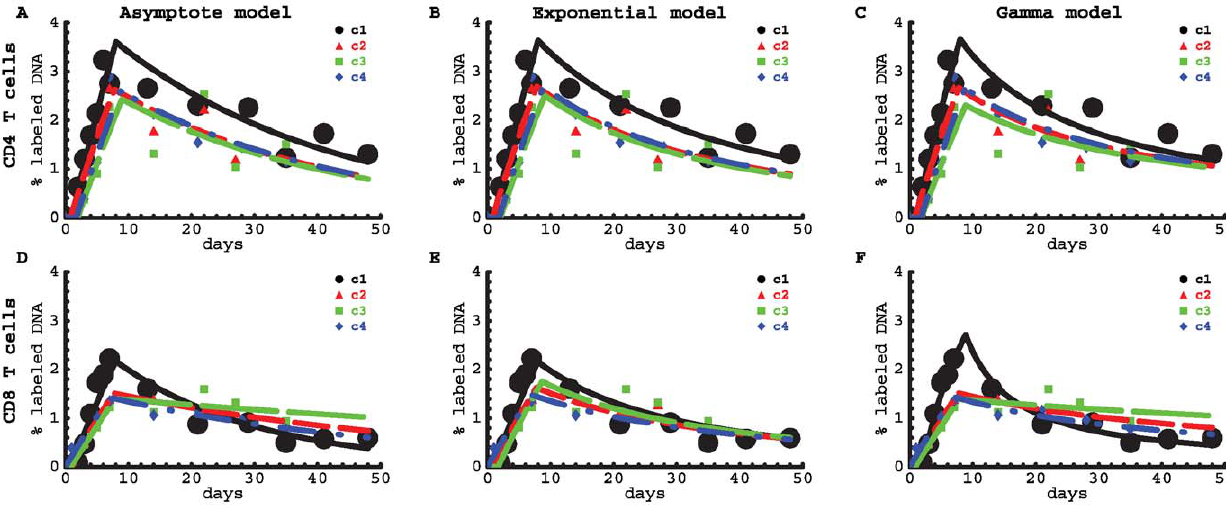
Figure 6. Fits of the deuterium labeling data with mathematica models. Data on labeling of CD4 + (top rows) and CD8 + (bottom rows) T cells in four healthy humans were fitted by three models: the Asymptote model (panels A and D), the Exponential model, in which a fraction a of cells have exponentially-distributed turnover rates (eqn. (8), panels B and E), and the Gamma model, with gamma-distributed turnover rates (eqn. (4), panels C and F). Experimental data obtained from Mohri et al. [2] are shown as symbols and the curves are the best model fits. The sum of squared residuals of the model fits to the data on the dynamics of CD4 + T cells are (6 : 19,5 : 94,5 : 87) | 10 { 3 for the Asymptote model, the Exponential model and the Gamma model, respectively. The sum of squared residuals of the model fits to the data on the dynamics of CD8 + T cells are (3 : 4,3 : 85,1 : 56) | 10 { 3 for the Asymptote model, the Exponential model and the Gamma model, respectively. Note that the two explicit kinetic heterogeneity models describe these data with similar (Exponential model) or even better (Gamma model) quality compared to the Asymptote model.